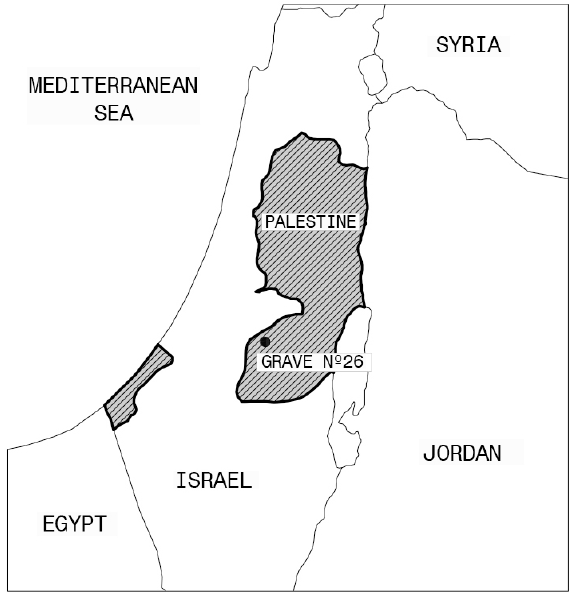
Figure 1. Location of the